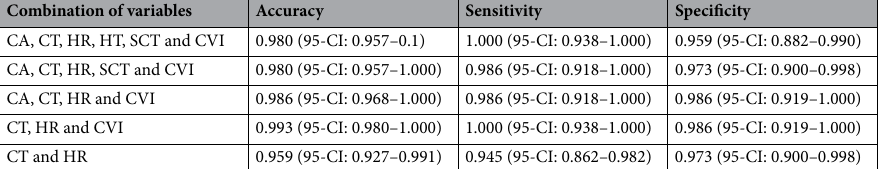
Table 2. Accuracy, sensitivity, and specificity of the choroidal measurements in various combinations. CA choroidal area, CI confidence interval, CT choroidal thickness, CVI choroidal vascular index, HR Haller ratio, HT Haller layer thickness, SCT Sattler-choriocapillaris thickness.